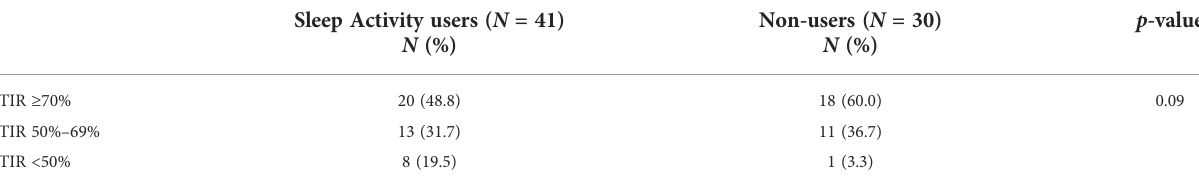
TABLE 4 Comparison by category of nighttime TIR between Sleep Activity Mode users (group 1) and non-users (group 2); analysis included patients using sensor and automatic mode ≥ 90% ( N = 71). Sleep Activity users ( N =